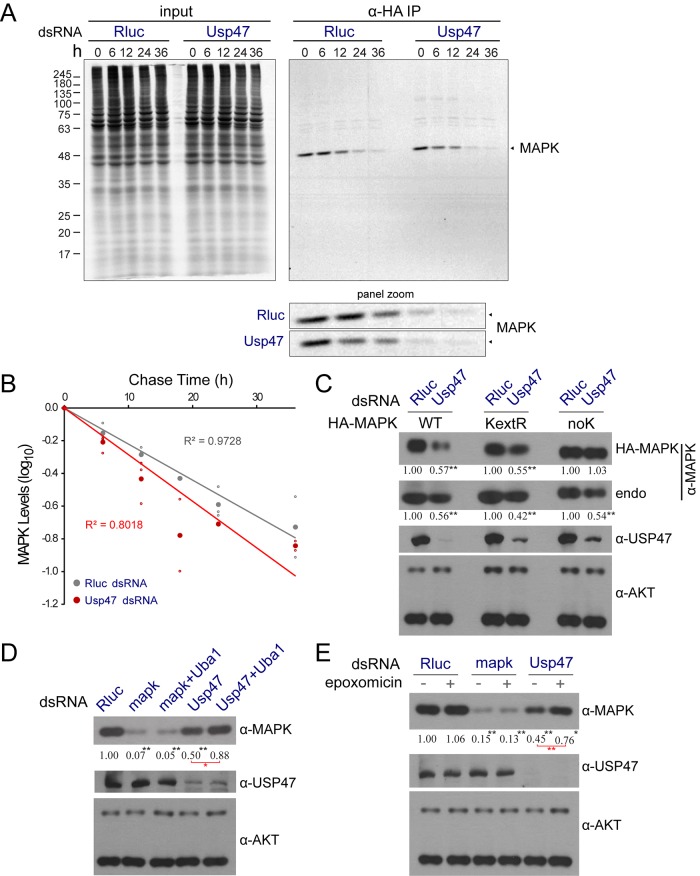
USP47 acts post-translationally on MAPK.(A) Pulse-chase experiments of [35S]-methionine labeled MAPK show an impact on MAPK half-life. S2 cells were treated with the indicated dsRNAs for 5 d followed by 6 h of [35S]-methionine labeling. Cell lysates were then prepared at the indicated time following the labeling period. (B) Densitometry quantification of three separate replicates of the experiment presented in A. MAPK levels were normalized to that of three bands from the input gel. Based on these results, MAPK half-life was reduced from 13.68 h (Rluc dsRNA controls) to 10.34 h (Usp47 dsRNA). (C) Usp47 dsRNA was added to cells stably expressing wild-type exogenous HA-tagged MAPK, causing a reduction in MAPK levels. Similar cell lines were established in which the 10 predicted surface exposed lysines (MAPKKextR; external lysines were selected based on the structure of ERK2 and correspond to residues 67, 68, 92, 127, 151, 164, 177, 216, 220, 283, and 313 of Drosophila MAPK) or all lysines (MAPKnoK) were switched to arginines. Only mutation of all of the lysines abrogated the sensitivity of MAPK levels to Usp47 depletion. (D) Depletion of the Drosophila E1 ligase, Uba1 (FBgn0023143; see S5 Table for qPCR validation of RNAi reagent), rescues the impact of Usp47 RNAi on MAPK levels. (E) Treating S2 cells with the epoxomicin proteasome inhibitor restored MAPK levels in a Usp47 depleted context. (C–E) Densitometry quantifications are provided for MAPK levels (normalized to the AKT loading controls). All immunoblots were performed in triplicate or more, and p-values were calculated (paired two tailed Student’s t test) comparing values to the Rluc control (*: p < 0.05; **: p < 0.01). t tests performed on other samples are shown in red. Raw data for (B–E) can be found in S1 Data.